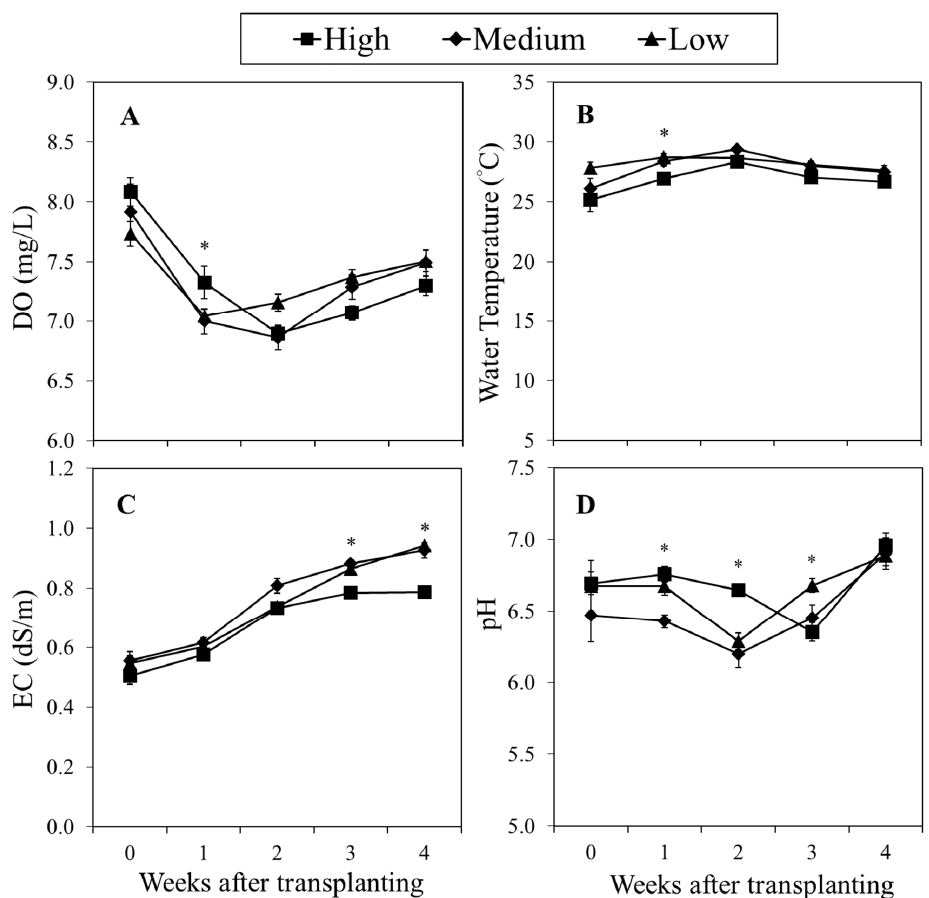
Figure 2. Weekly changes in ( A ) dissolved oxygen (DO), ( B ) water temperature, ( C ) electrical conductivity (EC), and ( D ) pH as a ff ected by flow rate treatments: high (HFR, 3.3 m / day), medium (MFR, 2.2 m / day), and low (LFR, 1.1 m / day) flow rate. Water samples were measured daily from fish tank and grow bed in the aquaponic system. Each data point is the weekly mean of 4 replicates ± SE. ns, *, **, *** mean no significant or significant di ff erences at p ≤ 0.05, 0.01, or 0.001, respectively. Table 3. Average concentrations of total ammonia nitrogen (TAN), nitrite (NO 2 –N), nitrate (NO 3 –N), phosphate (PO 4 –P), and sulfate (SO 4 –S) in aquaponic solution as a ff ected by high (HFR, 3.3 m / day), medium (MFR, 2.2 m / day), and low (LFR, 1.1 m / day) flow rate. Water samples for analyses were collected from fish